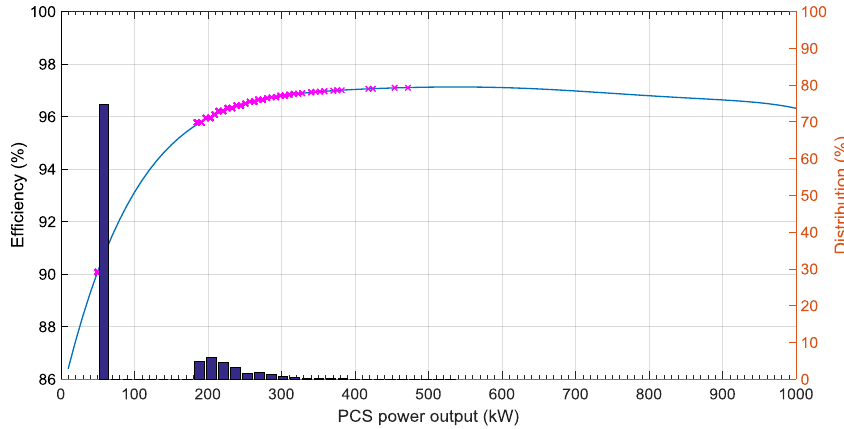
Figure 5. Energy storage unit (ESU) operation efficiency and distribution according to the uniformly assigned power.